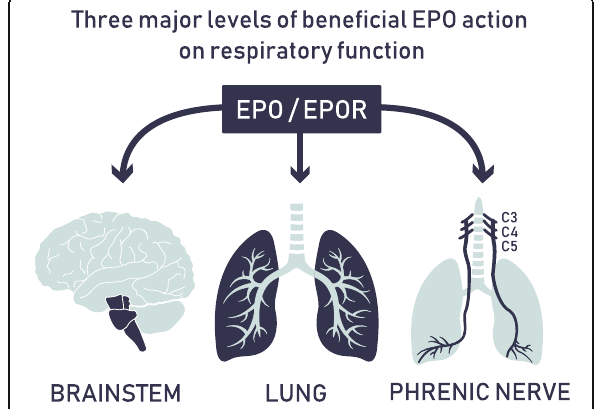
Fig. 1 Beneficial pleiotropic EPO effects on respiratory function target several levels, comprising brainstem and central respiratory command, lung, including protection of overall tissue homeostasis, as well as phrenic motor facilitation and spinal plasticity in respiratory motor